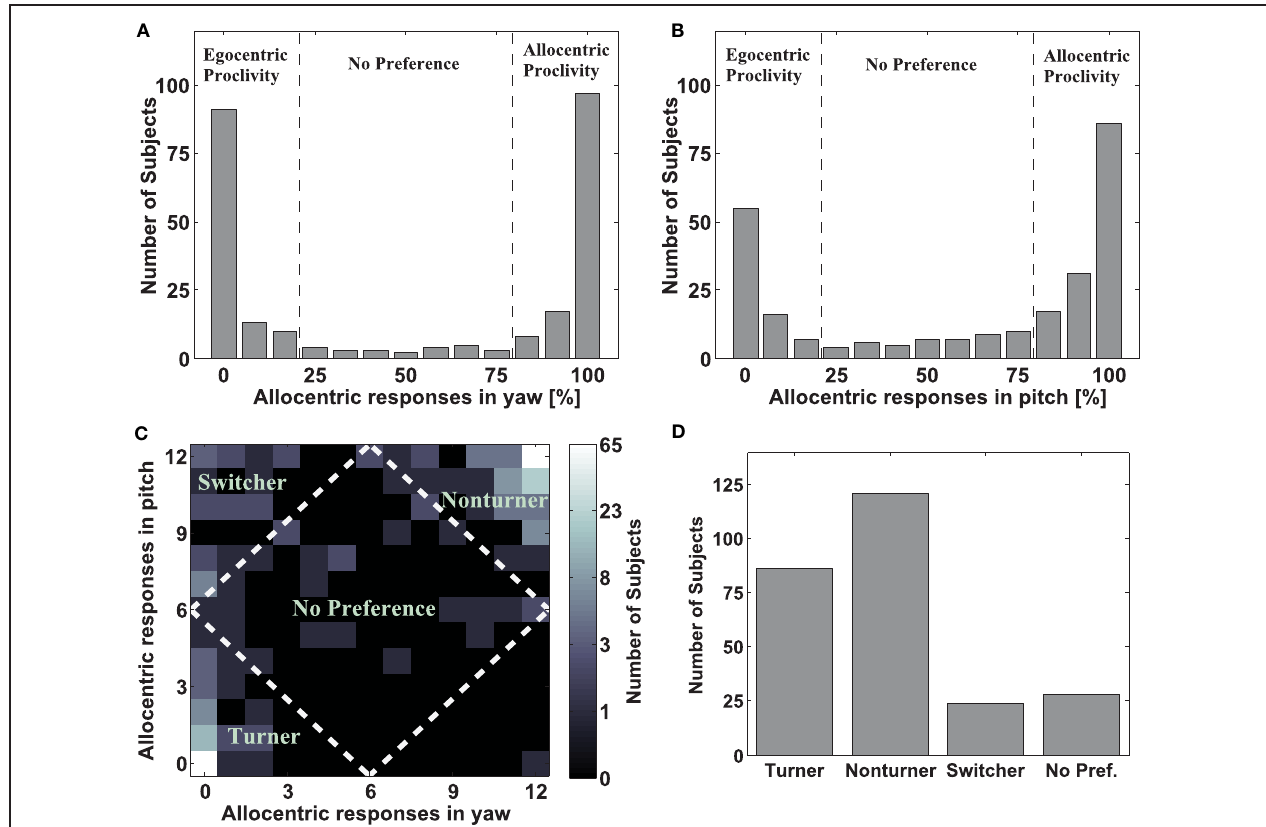
FIGURE 3 | Response distribution and strategy formation. (A,B) Histograms of responses for yaw (panel A ) and pitch (panel B ) rotations. In both figures the y-axes indicate the number of subjects. The x-axes show the amount of allocentric responses. The height of the gray bars indicates the amount of subjects for each ratio of allocentric vs. egocentric responses (0 means all responses were given using and egocentric reference frame; 100 means all responses were given using an allocentric reference frame). The black dashed lines indicate the boundaries that were later on used to group people into different strategy classes. (C) Combined response pattern for all subjects indicating strategy class. The y-axis indicates the amount of allocentric responses in pitch, the x-axes indicates the amount of allocentric